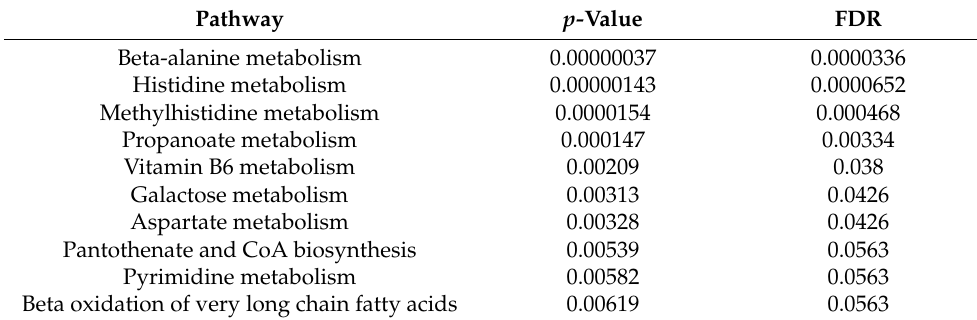
Table 5. Active metabolic pathways in participants who received animal protein